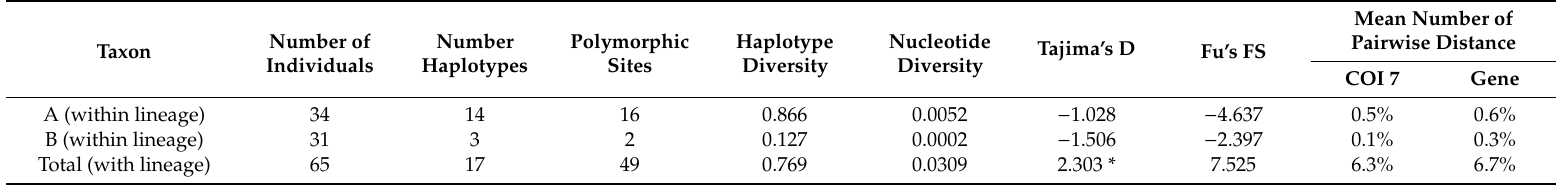
Table 3. Summary of genetic diversity measures and neutrality tests between and within lineages based on the COI gene, and the mean number of pairwise distances based on a fragment of the COI gene and on a combination of seven